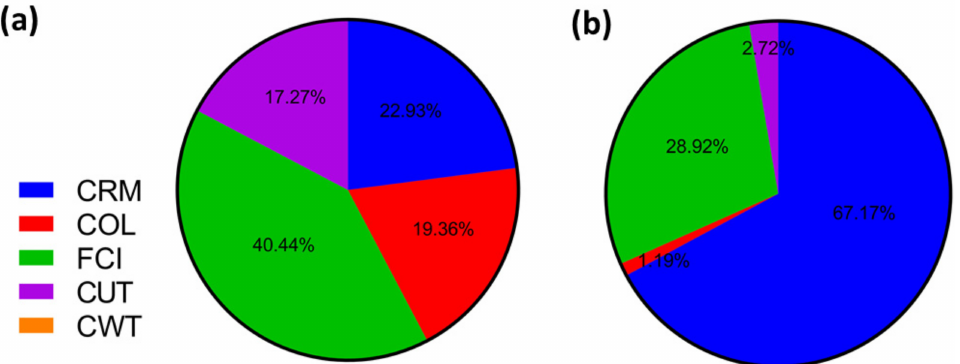
Figure 7. Contribution of each component. CRM: cost of raw material; FCI: fixed capital investment; COL: cost of operational labor; CUT: cost of utilities on the COM for quinoa protein hydrolysate obtained by conventional solvent extraction (CSE) for ( a ) laboratory scale and ( b ) industrial